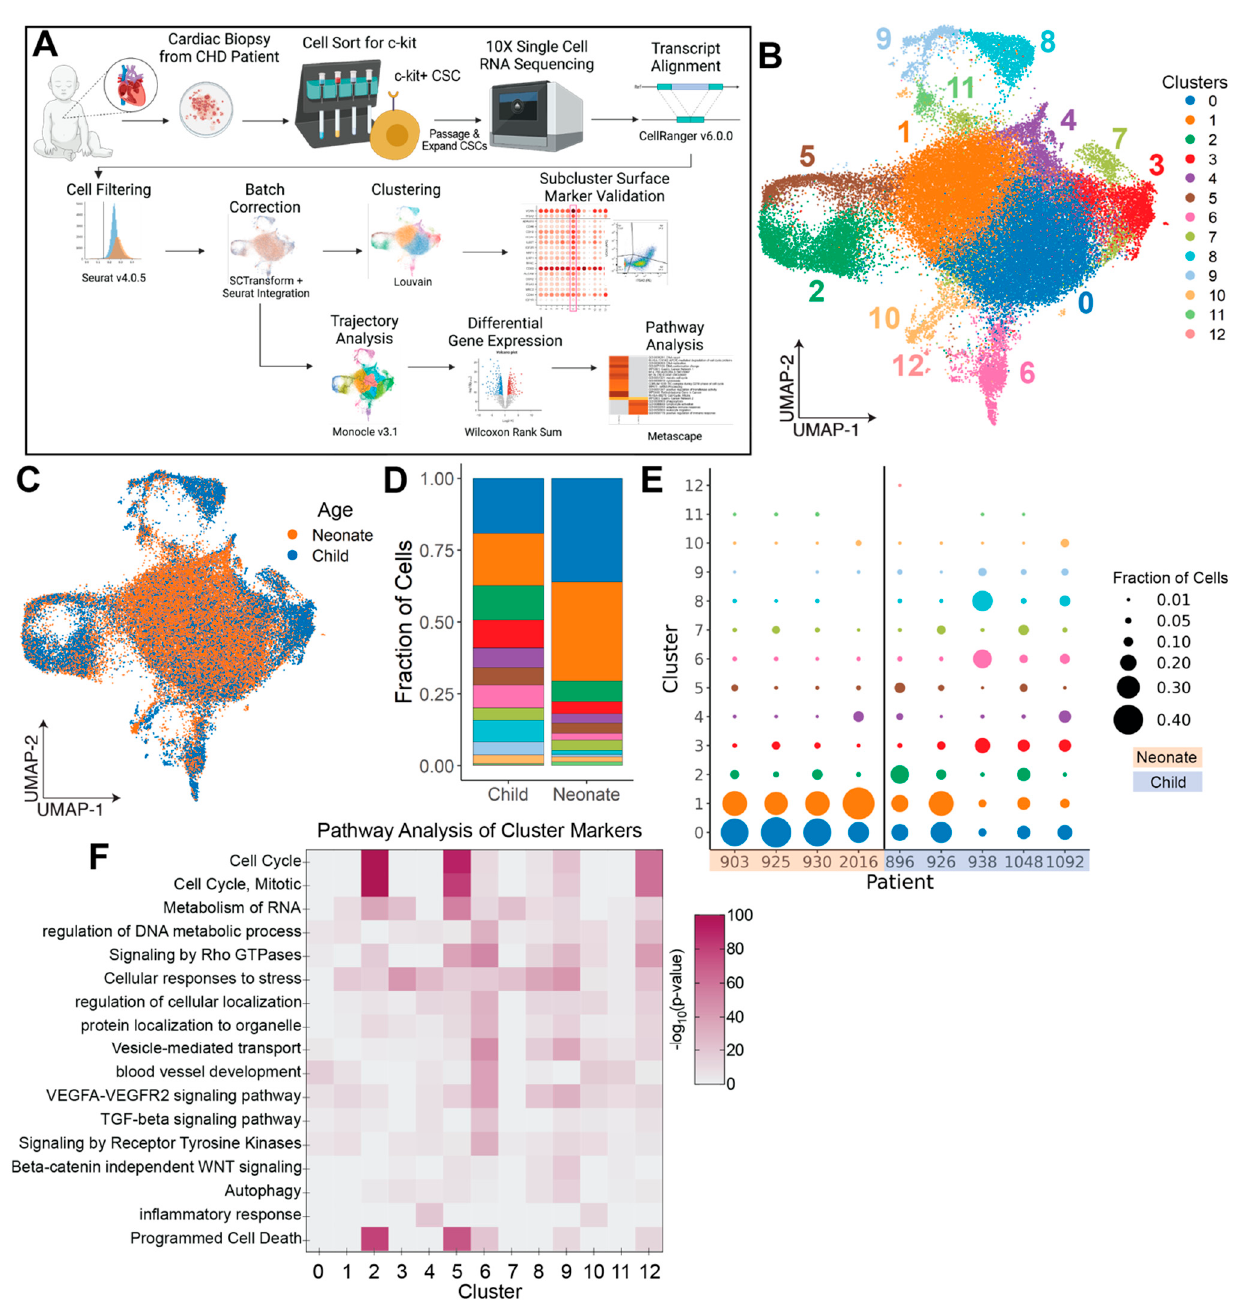
Figure 1. Clustering and cluster compositions of nCSCs and cCSCs. ( A ) Top sequence: CSC isolation from CHD patients and culture. Bottom sequence: analysis pipeline and computational tool summary. Figure generated in BioRender. UMAP projections of all patient-derived CSCs colored by ( B ) cell cluster and ( C ) age group. Cluster composition as grouped by ( D ) age group and ( E ) patient sample. ( F ) Enrichment of selected pathways from positive cluster marker gene sets, as listed in Table S6.